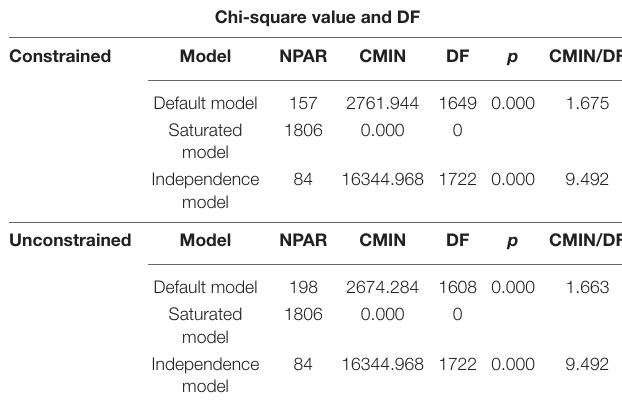
TABLE 6 | The chi-square value and DF for the constrained and unconstrained models for experienced teachers